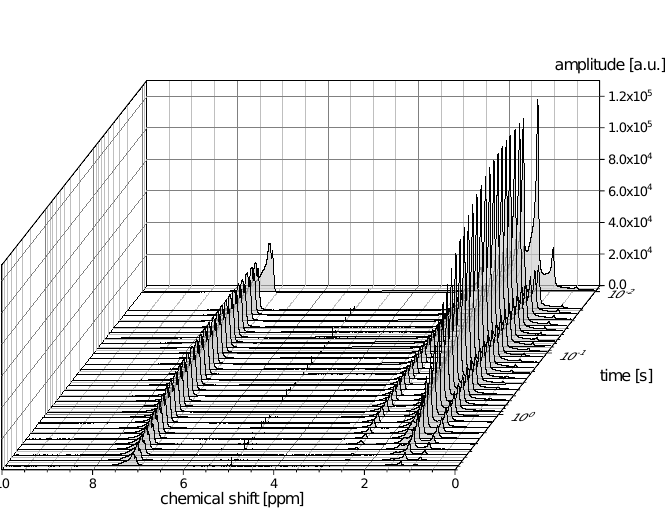
Figure A2. Longitudinal ( a ) and transverse ( b ) relaxation of decylbenzene in the asphaltene-free solution. The chemical shift axis is normalized to the dominant peak in the spectrum at 1.26ppm, which results from the seven CH 2 groups, most apart from the phenyl ring. Due to the spectral resolution the signal from the aliphatic chain (0ppm–3ppm) and from the phenyl ring (6ppm–8ppm) are well distinguishable and the relaxation of each part can be evaluated separately.